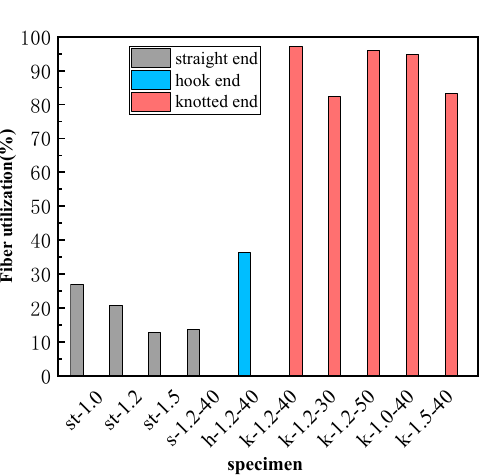
is consistent with the influence of pullout stress and bond-bearing capacity. The strength utilization rate of the hook end SMA fiber is only 36.3%, further explaining that the hook end cannot effectively utilize the superelasticity of the SMA material. For knotted end SMA fibers the strength utilization ratio can be more than 80%, and the highest fiber utilization ratio comes from specimen k-1.2-40, which reaches 97.2%. Comparing specimens k-1.2-30, k-1.2-40, and k-1.2-50, which are different in bond lengths, their SMA fiber